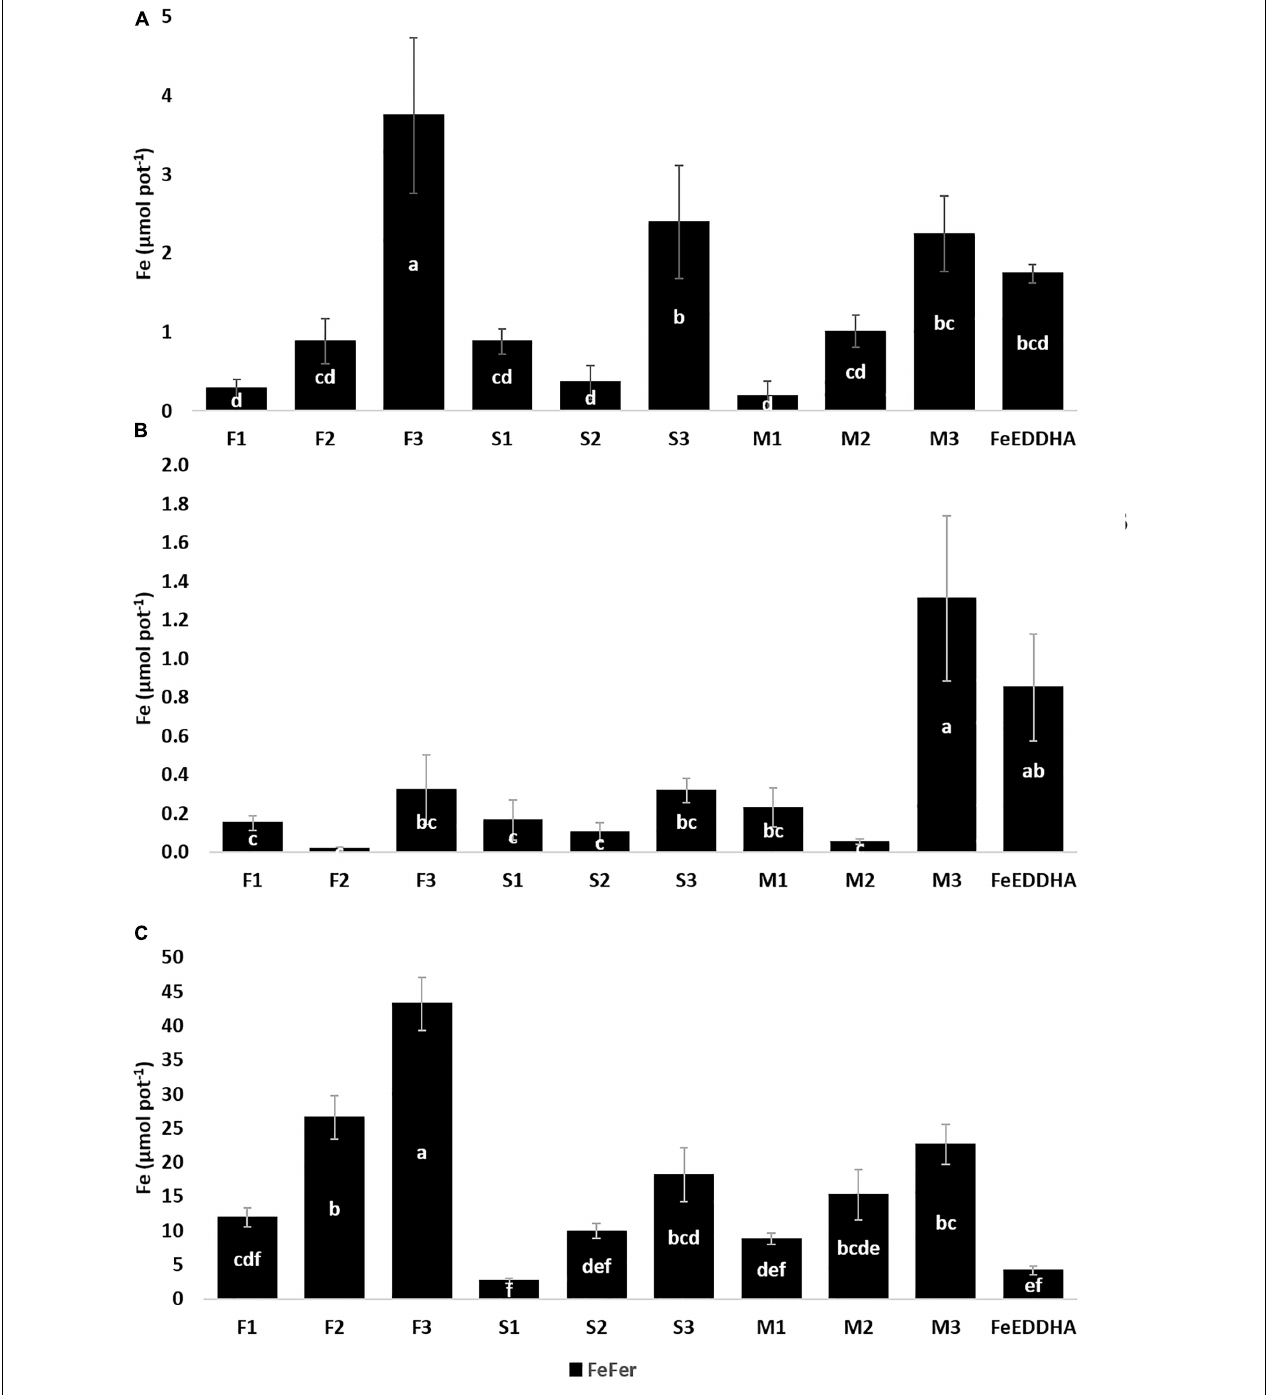
FIGURE 9 | Fe Fer ( µ mol pot − 1 ) content in soybean roots of plants fertilized with the 57 Fe products F, S, and M in three doses: (1) 35, (2) 75, and (3) 150 µ mol 57 Fe pot − 1 or 50 µ mol 57 FeEDDHA pot − 1 (A) , soluble soil fraction (B) , and available soil fraction (C) at 48 DAF. For each series different letters denote significant differences among the treatments according to Duncan’s Test ( p < 0.05). Results are expressed as averages ± standard error, n =